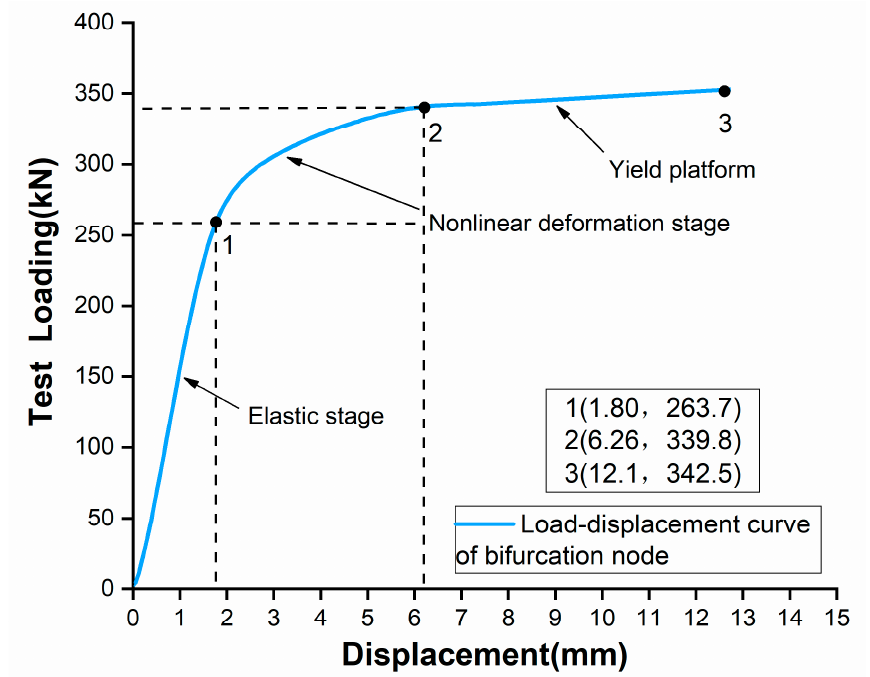
Figure 15. Load–displacement curve of the Figure 15. Load – displacement curve of the specimen.